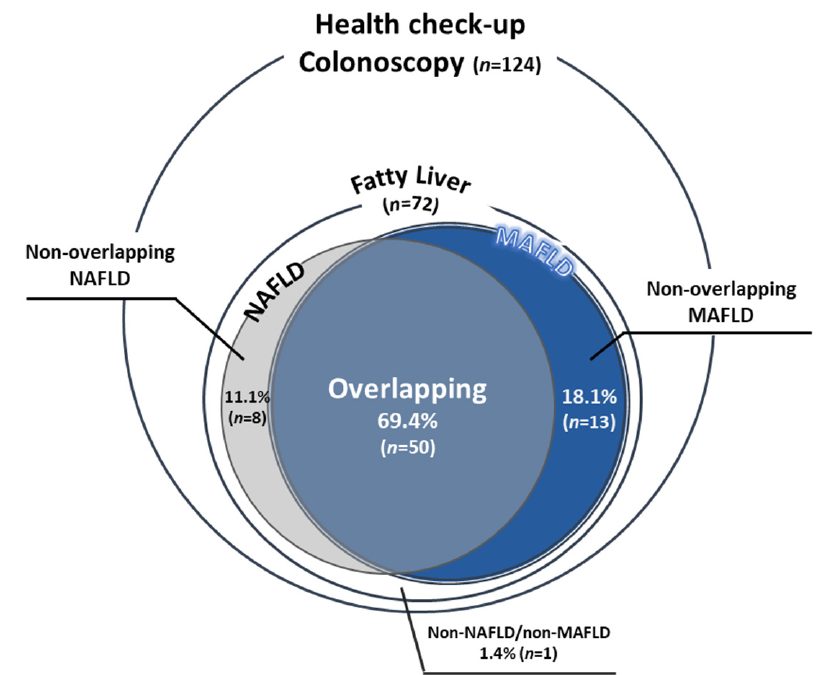
Figure 1. The population of MAFLD and NAFLD. The Venn diagram indicates the proportion of patients with NAFLD (gray) and patients with MAFLD (blue).